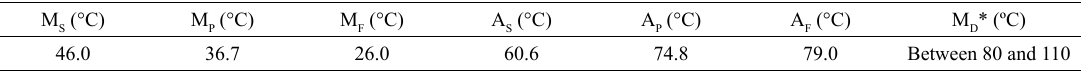
Table 1. Direct and reverse martensitic transformation temperatures of the solution treated 2.080 mm in diameter wire.